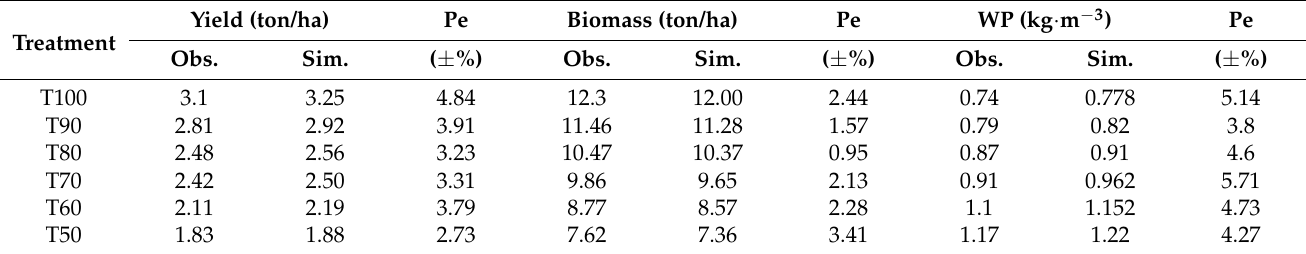
Table 9. The results of model validation for grain yield, biomass, and water use efficiency for barley crop under different irrigation conditions (2019).